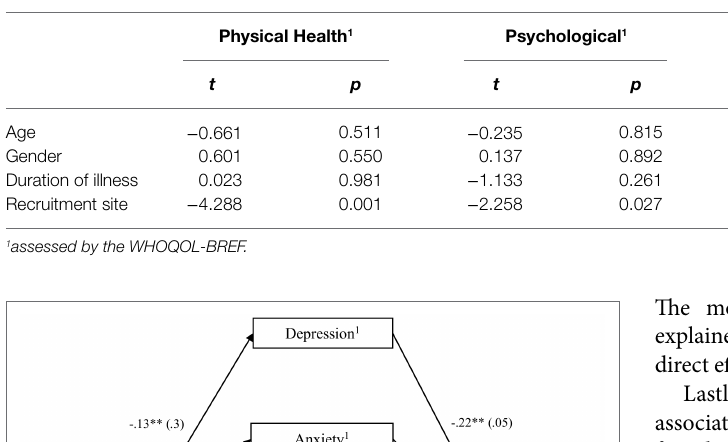
TABLE 5 | Potential covariates and their effects on quality of life domains.